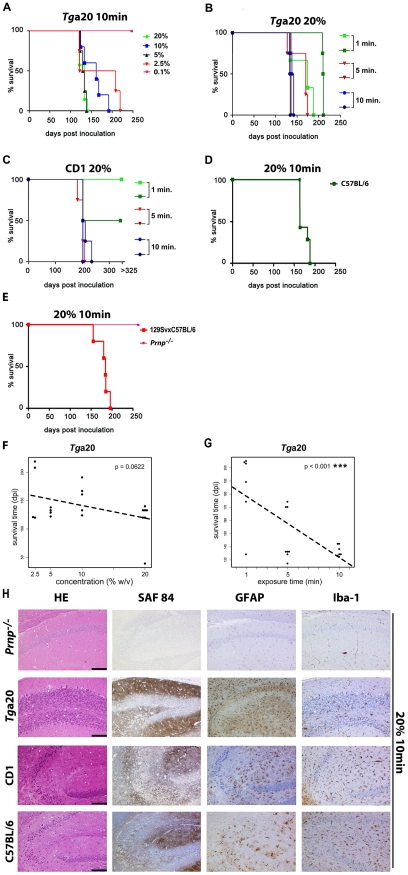
Prion transmission through aerosols.(A) tga20 mice were exposed to aerosols generated from 0.1%, 2.5%, 5%, 10% or 20% prion-infected mouse brain homogenates (IBH) for 10 min. (B) Groups of tga20 and (C) CD1 mice were exposed for 1, 5 or 10 min to aerosols generated from a 20% IBH. Experiments were performed twice (different colors). (D) C57BL/6, (E) 129SvxC57BL/6, and Prnp
o/o mice were exposed for 10 min to aerosols generated from 20% IBH. Kaplan-Meier curves describe the percentage of survival after particular time points post exposure to prion aerosols (y-axis represents percentage of living mice; x-axis demonstrates survival time in days post inoculation). Different colors and symbols describe the various experimental groups. (F) Jittered scatter plot of survival time against concentration of prion aerosols generated out of IBH with added linear regression fit (p = 0.0622). (G) Jittered scatter plot of survival time against exposure time for tga20 mice with added linear regression fit. The negative correlation between survival time and exposure time is significant (p<0.001***). (H) Consecutive paraffin sections of the right hippocampus of Prnp
o/o, tga20, CD1 and C57BL/6 mice stained with HE (for spongiosis, gliosis, neuronal cell loss), SAF84 (PrPSc deposits), GFAP (astrogliosis) and Iba-1 (microglia). All animals had been exposed to aerosols generated from 20% IBH for 10 min. Scale bars: 100µm.